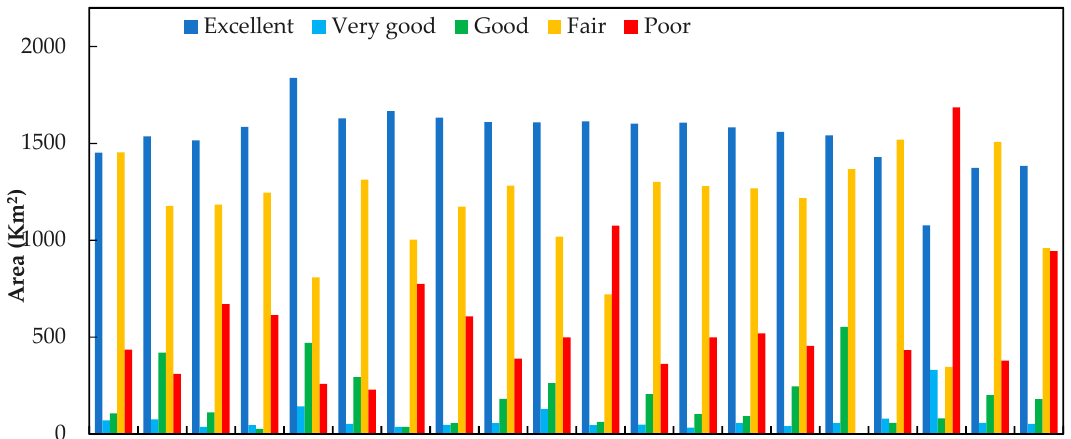
Figure 16. The areas of surface ecological conditions classes.